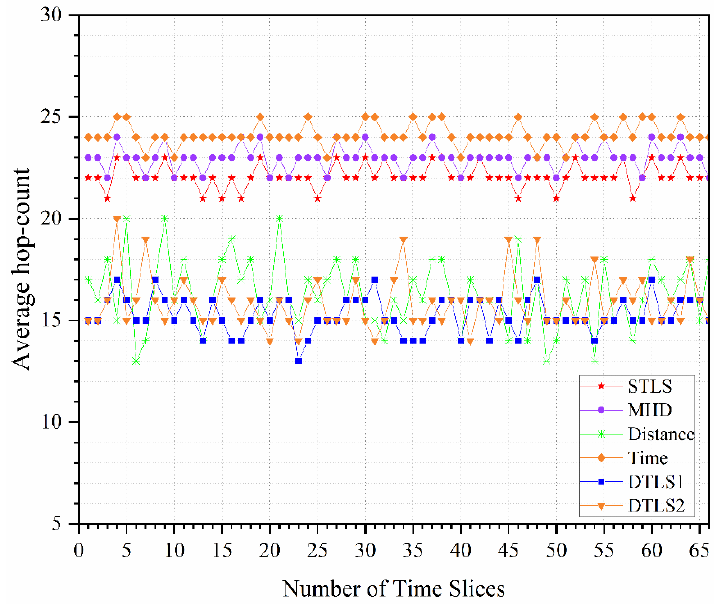
Figure 7. Comparison of packet forwarding hops in the six topology cycles.